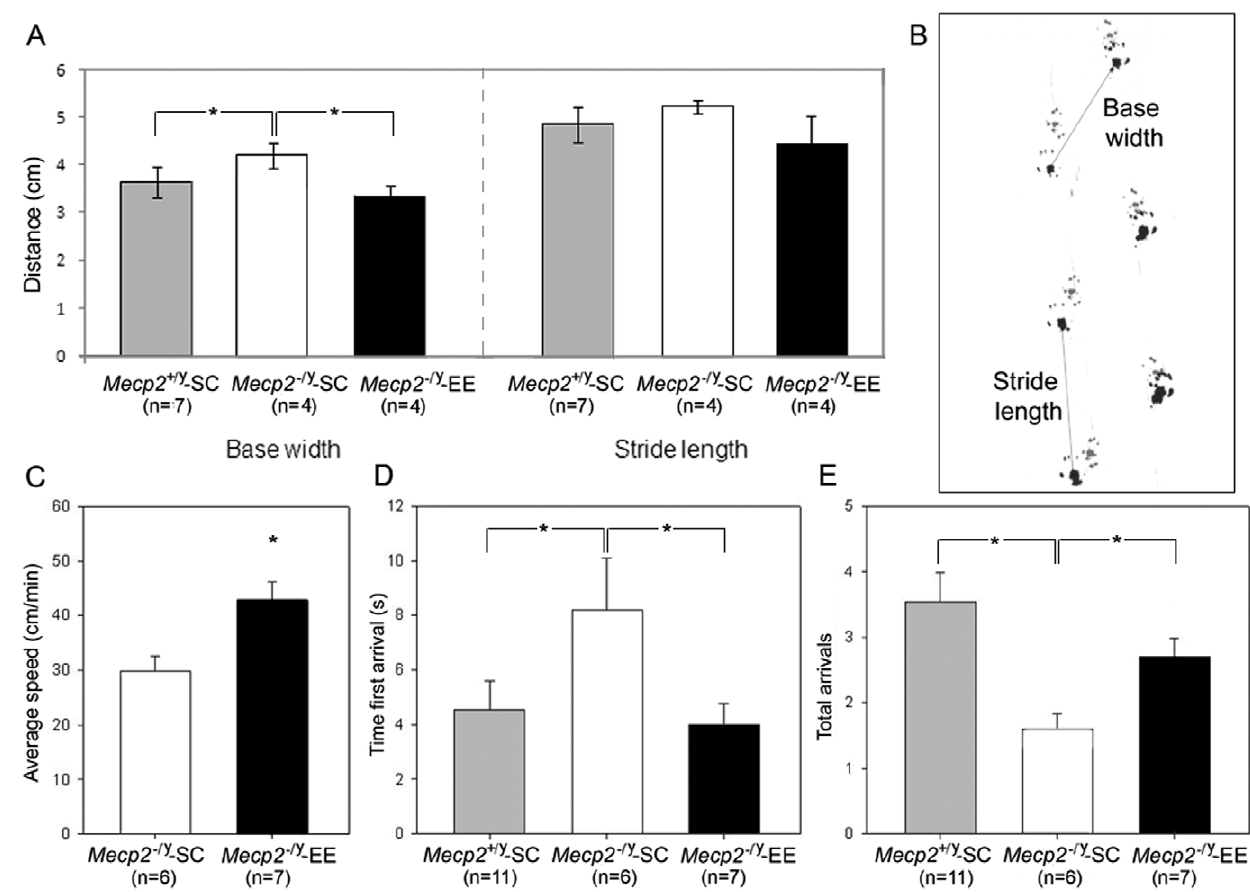
Figure 2. Environmental Enrichment improves neuromotor dysfunction in Mecp2 2 /y mice. A, Footprint analysis showed impaired walking patterns in Mecp2 2 /y -SC mice compared with Mecp2 2 /y -EE and Mecp2 + /y 2 SC control animals. B, Measures taken for footprint analysis .C, Speed of movement (cm/s) was faster for Mecp2 2 /y -EE than Mecp2 2 /y -SC mice. D, Mecp2 2 /y -EE mice displayed improved motor coordination compared with Mecp2 2 /y -SC evidenced by a shorter time to reach the platform for the first time and E, higher number of arrivals to the platform in the elevated